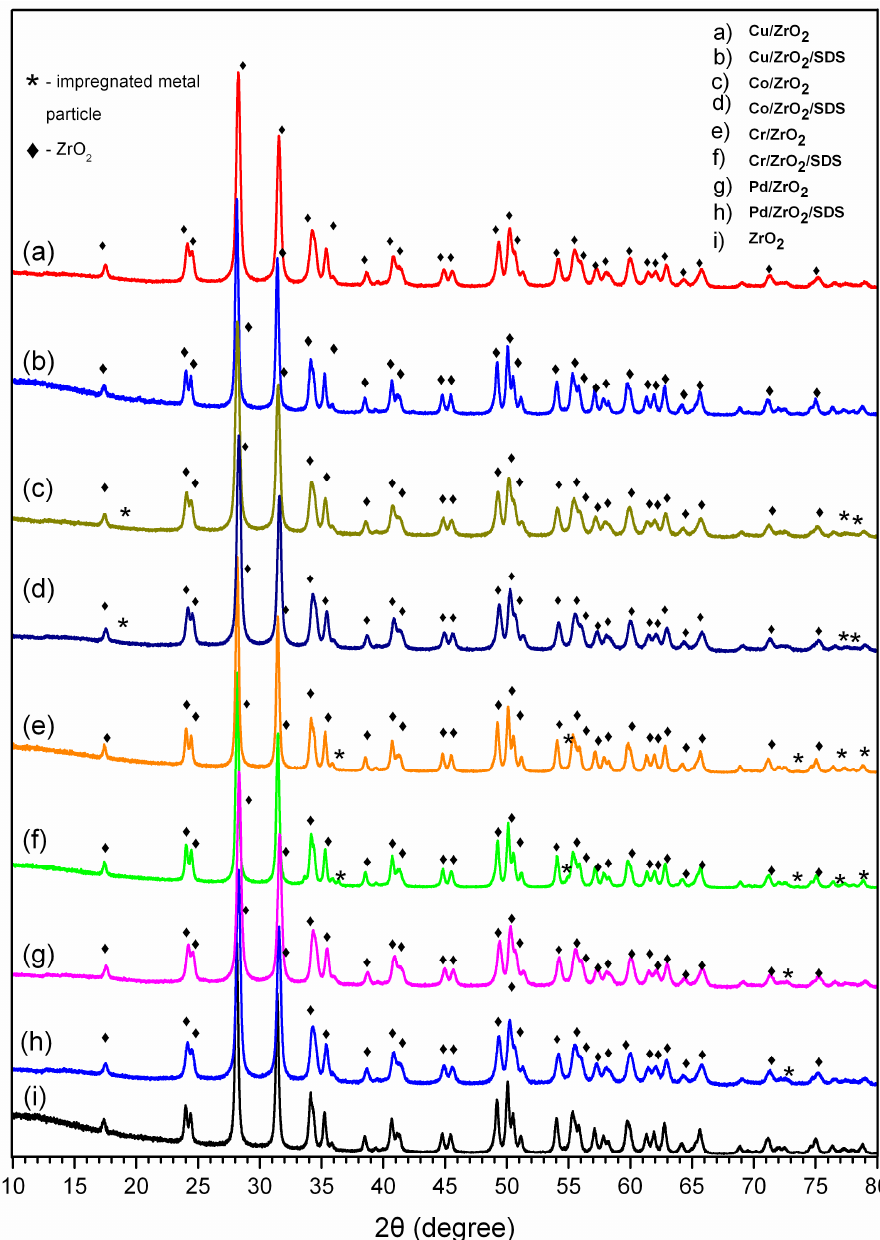
Figure 4. XRD patterns of prepared catalyst samples.